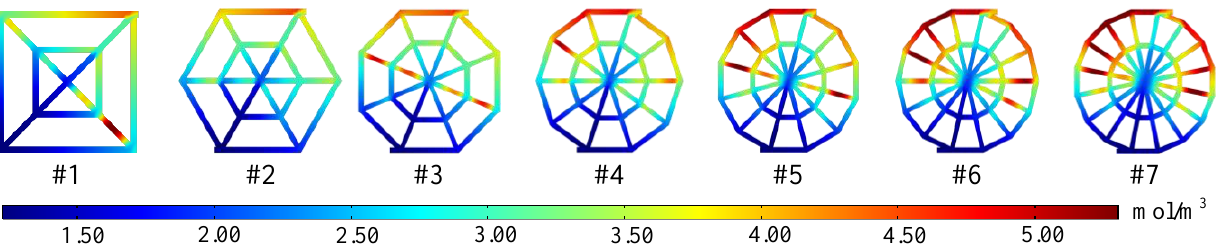
Figure 9. The water distribution of schemes #1 to #7 in the cathode flow field. According to the analysis of oxygen distribution in Figure 6, in the second half of the flow field, continuously increasing the number of polygonal sides, the role of the included angle gradually dominated, and the remaining oxygen tended to accumulate in the flow channels due to the lack of flow pressure and the reduction in the flow velocity. At this time, in these flow channels, the water generated by the reaction and carried here by oxygen also accumulated here because the remaining oxygen could no longer effectively purge them to the outlet. In contrast, in the flow field with a small number of polygonal sides, the difference between the effect of the inflection points and the included angle on oxygen transport was smaller, and the uniformity of oxygen distribution and its concentration in the second half of the flow field was higher, so the water removal capacity of such schemes was better. Similarly, as shown in Figure 10, increasing the number of layers had a positive effect on the performance of water removal. The improvement was mainly reflected in the reduction in water concentration in the connecting flow channels. After increasing the number of layers, the length of the connecting flow channels gradually shortened and it was easier for oxygen to diffuse through them, so the removal effect of water in these flow channels was relatively better. In contrast, the water concentration in the spiral flow channels, especially in the outermost channels near the outlet, did not decrease with the increase in the number of layers.